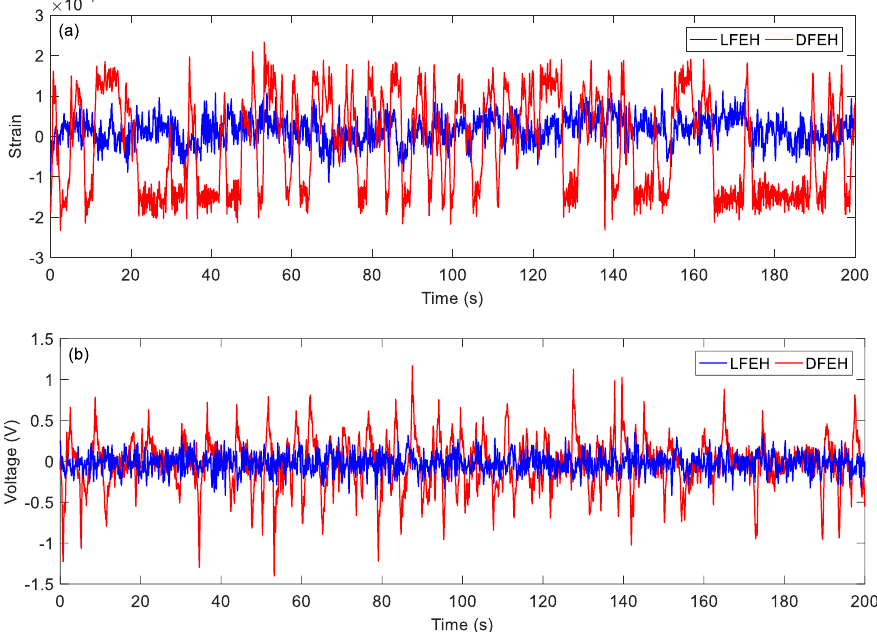
Figure 12. ( a ) Time histories of strain response, ( b ) time histories of voltage response ( v = 3.5 m/s).